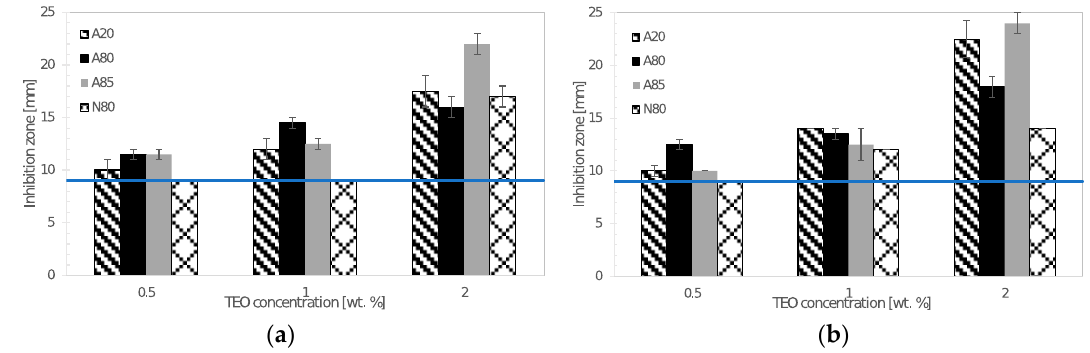
Figure 5. Inhibition zones of chitosan films against ( a ) Escherichia coli and ( b ) Salmonella typhimurium . The straight line indicates the control chitosan sample.